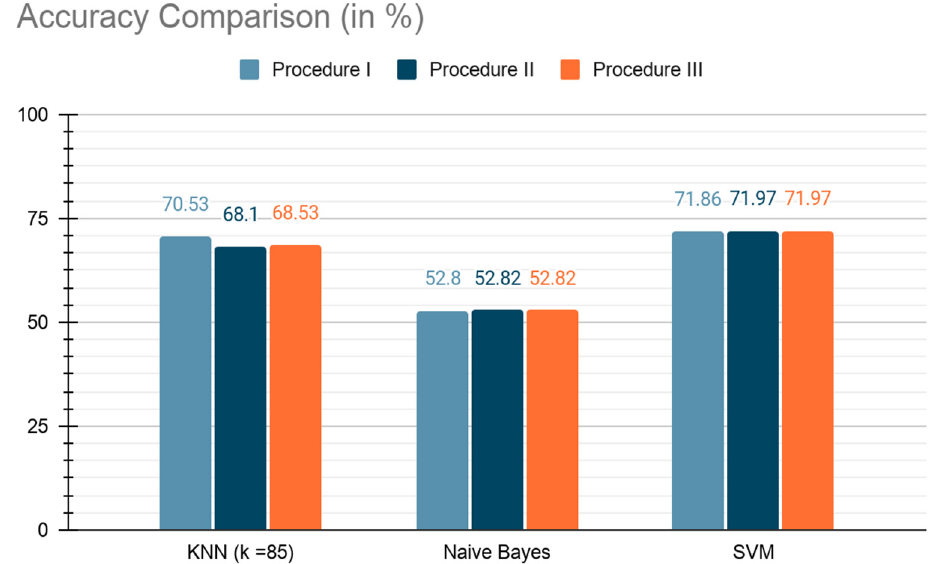
Figure 3. Performance comparison with different procedures for all three algorithms. SVM outper- formed the other two algorithms. Additional dimension reduction procedures also slightly improved its accuracy; it was the only algorithm to benefit from these additional steps. KNN, with k = 85, provided very comparable results with SVM when all attributes were trained (Procedure 1 in the figure). However, the additional dimension reduction step decreased its performance. Naïve Bayes performed poorly, unlike that reported in many other wineinformatics studies.